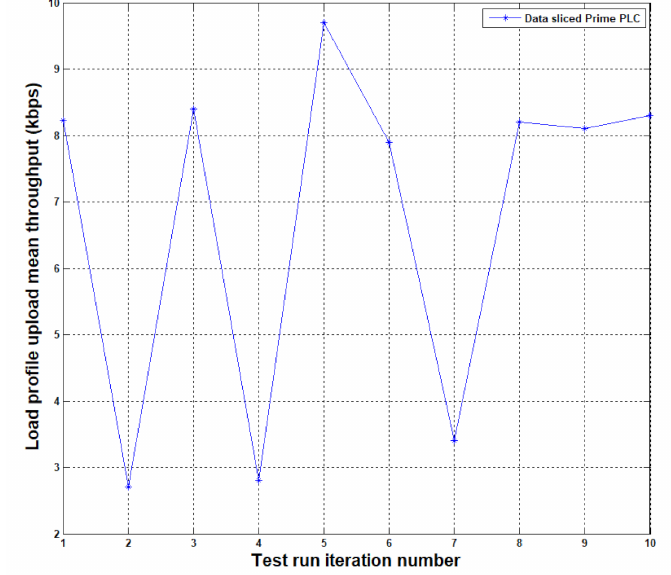
Figure 8. Thresholds observed on PLC-A to PLC-C communication channel with data slicing at the application